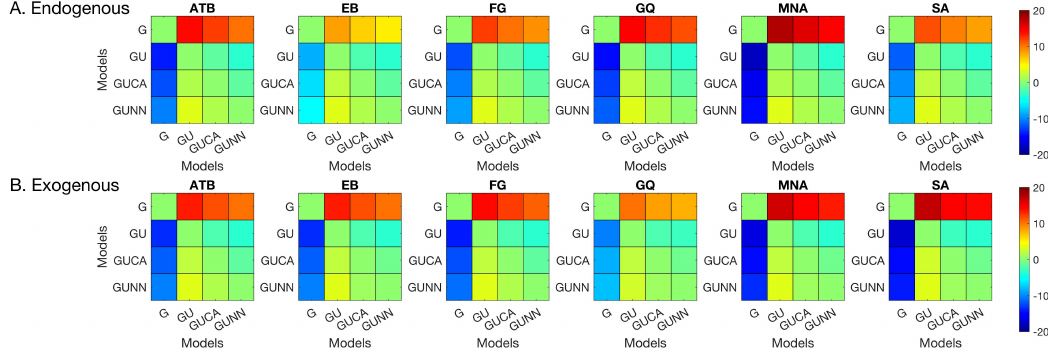
Figure 5. Pairwise Bayesian Model Comparison (BMC) differences between the statistical models tested. A square with coordinates (x,y) on each plot represents the BMC difference between model y and x. In order to have the same color notation (i.e., cooler colors mean better model performance and hotter colors mean worse model performance) as in Figure 4, we flipped the sign of the BMC differences. For both types of attention and for all observers, the GU model performs best in explaining the distribution of signed response errors, as indicated by the darkest blue color at the (G, GU) coordinate in all